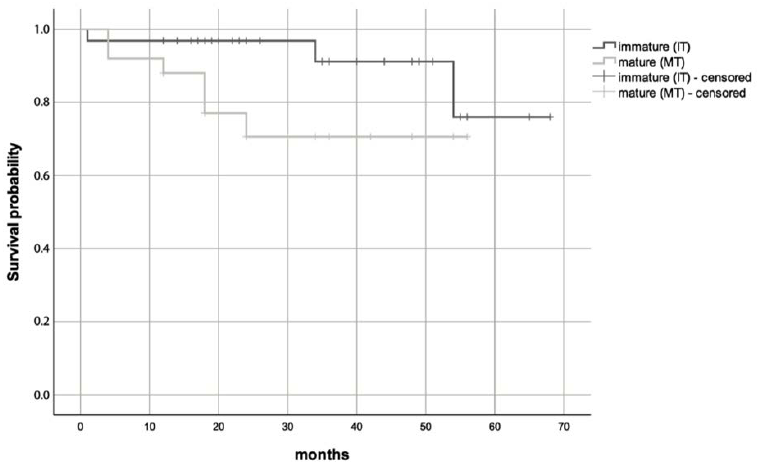
Figure 3. Comparison between the autotransplantation of immature (IT) and mature teeth (MT)— resorption-free